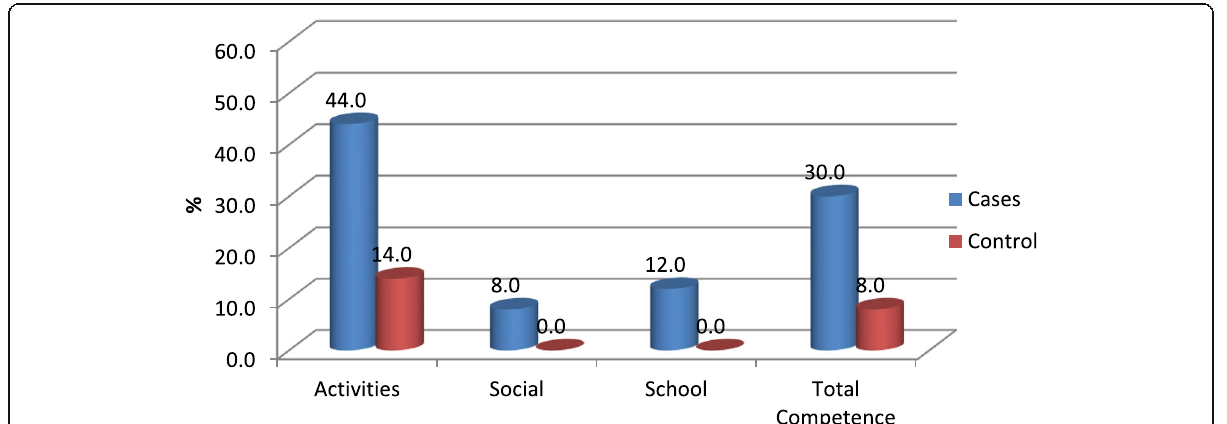
Fig. 3 Frequency distribution of different levels of competence scale of CBCL among dyslexic and control group